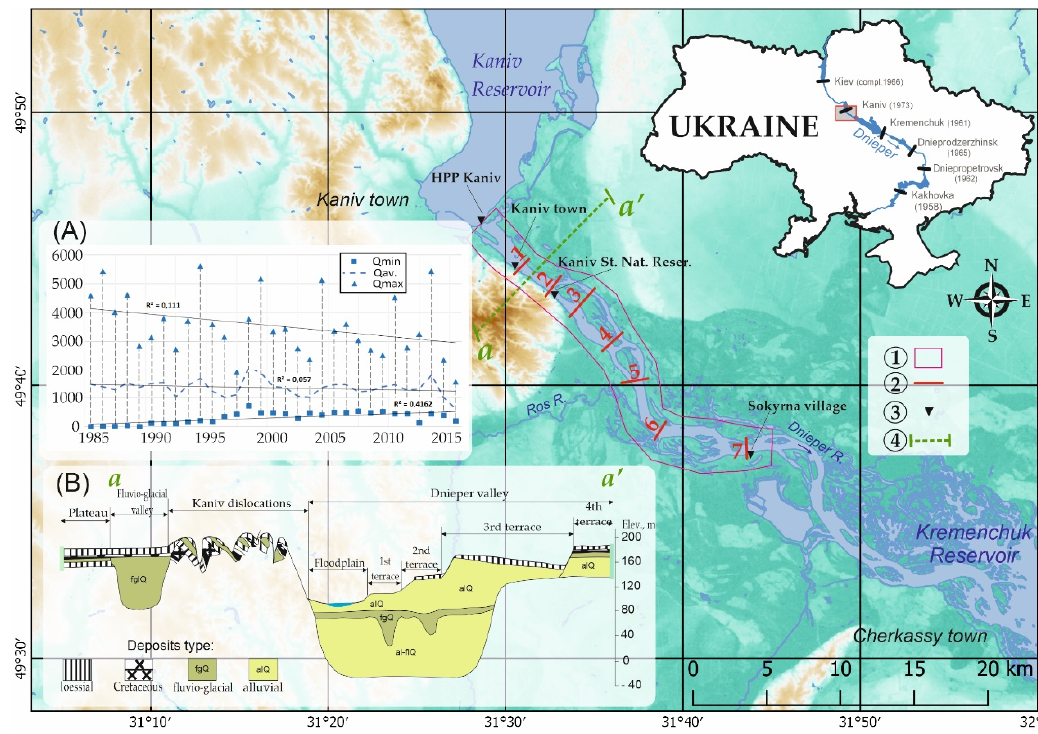
Figure 1. Map of the study area with the location of investigation sites on the Middle Dnieper river. ( A ) hydrograph of Dnieper flows (in m 3 ·s −1 ) at Kaniv town gauging station for the period 1985–2015 [55]; ( B ) geological and geomorphological profile of the river valley. 1—study area; 2—cross-channel profiles, 3—hydrological gauging stations, 4—geological cross-section below Kaniv dam a-a’ [52].